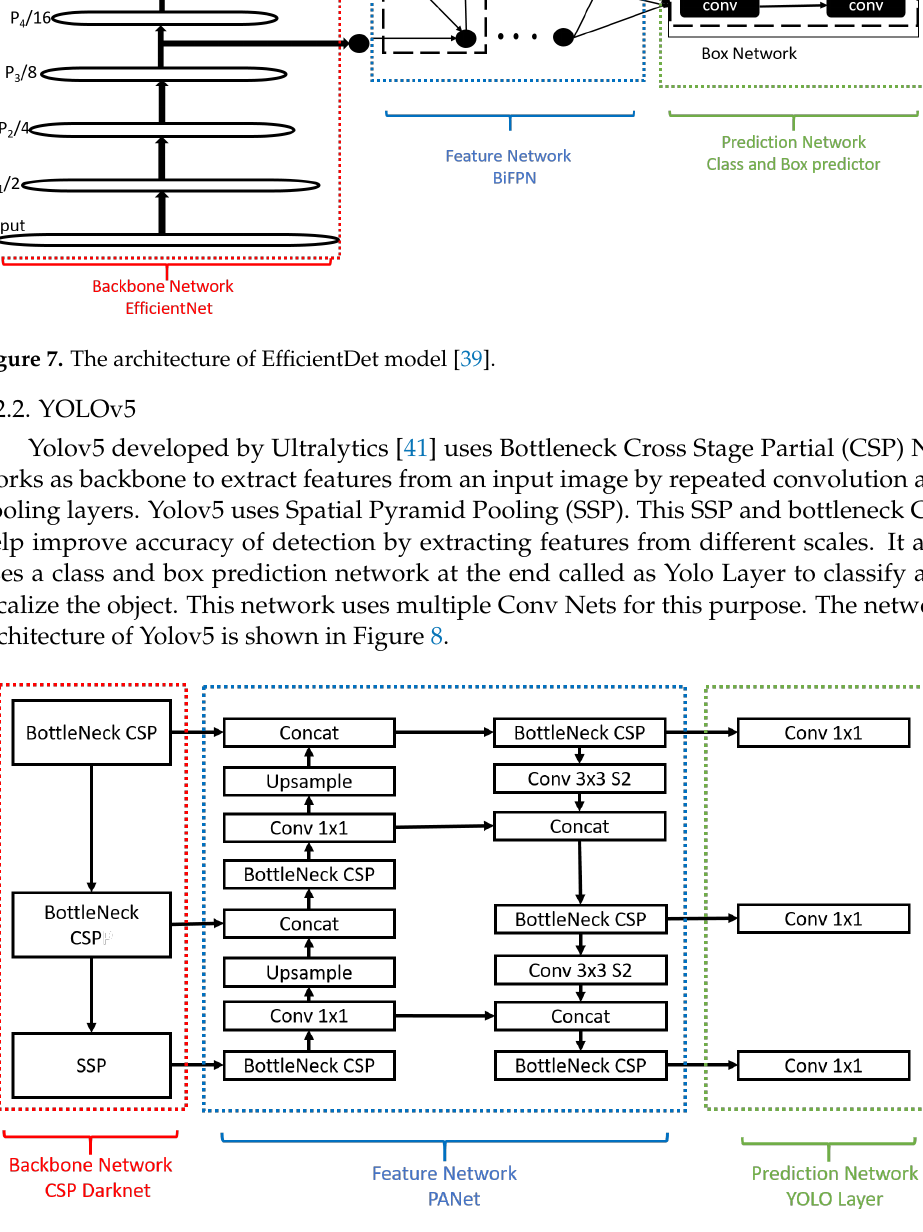
Figure 8. The architecture of Yolov5 model